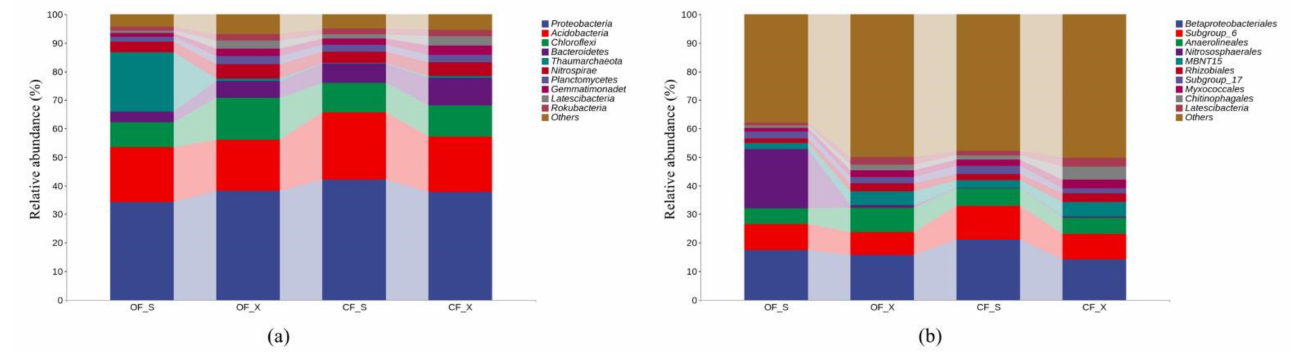
Figure 4. Relative abundance of bacteria at ( a ) phylum level and ( b ) order